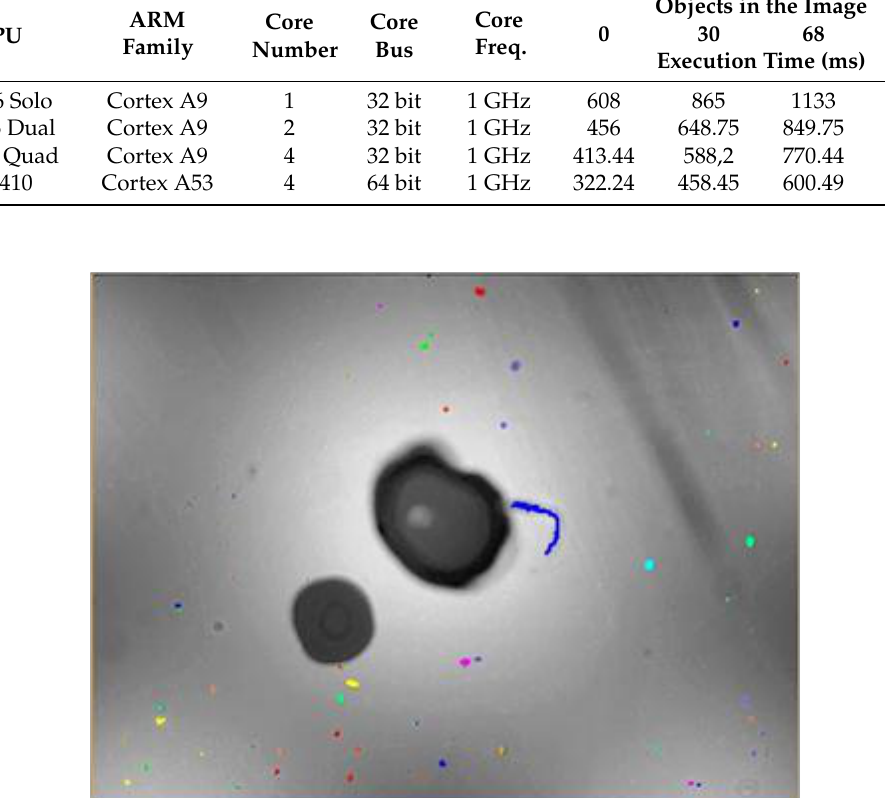
Table 5. Particle detection and classification execution time using the different CPUs architectures. Table 6. Particle classification results according to ISO 4406 size groups for the sample image of Figure 21.